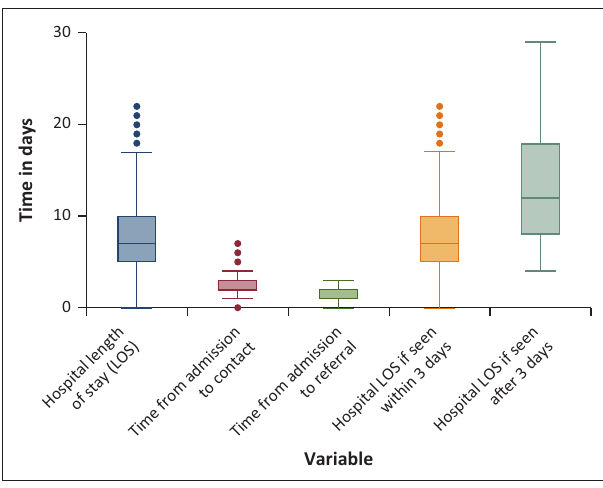
FIGURE 2: Box and whisker plots for various length of hospital stay intervals evaluated for the stroke survivors.